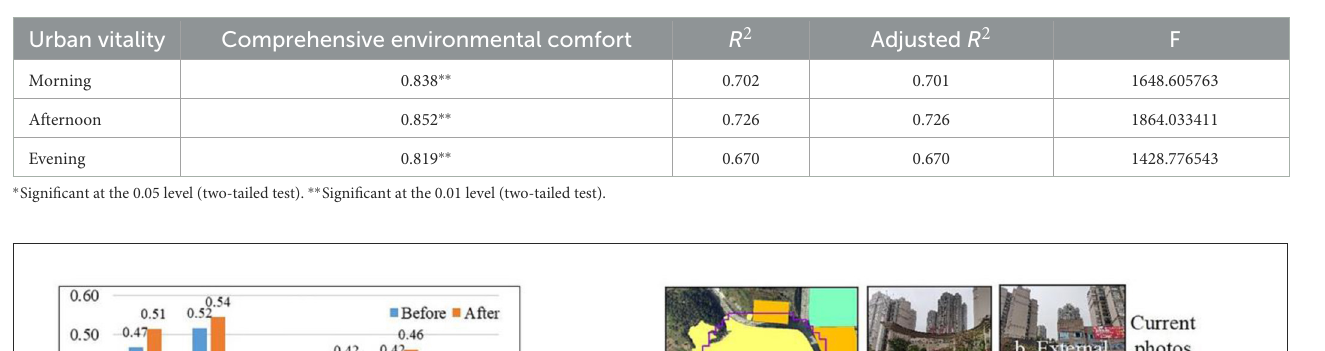
FIGURE7 Vitality before and after adjustments of environmental factors in residential areas.